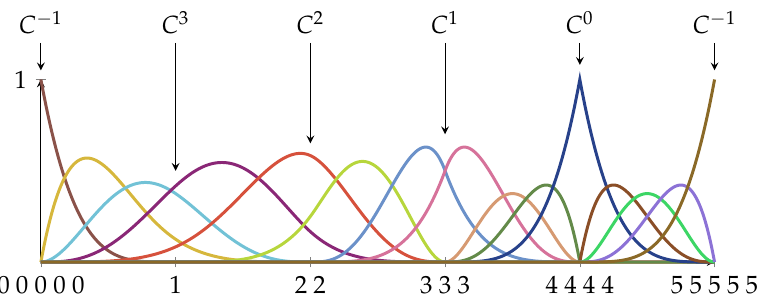
Figure 1. Different continuities across knotspans, based on [45].